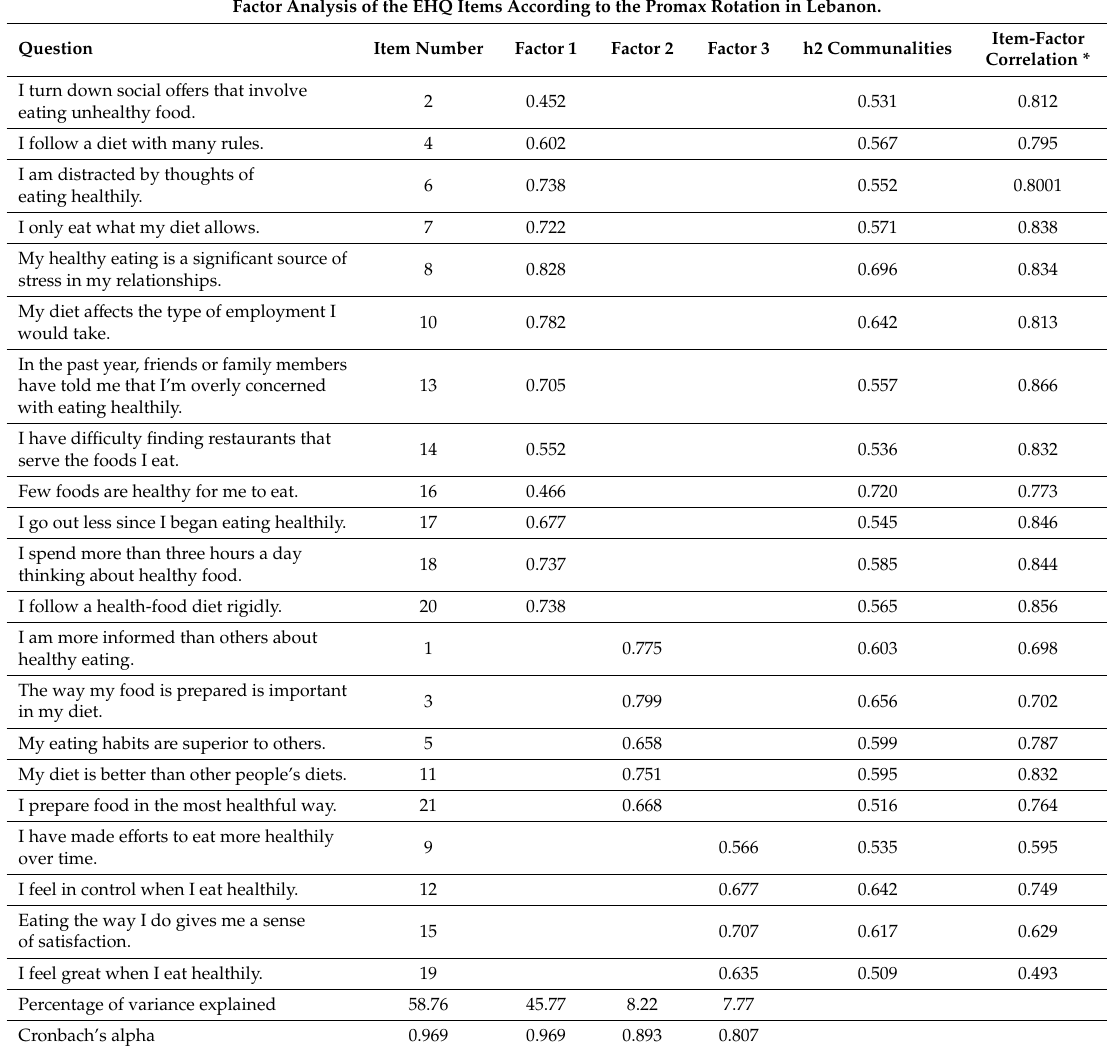
Table 3. Factor analysis of the Eating Habits Questionnaire (EHQ) items in a Lebanese Sample. Factor Analysis of the EHQ Items According to the Promax Rotation in